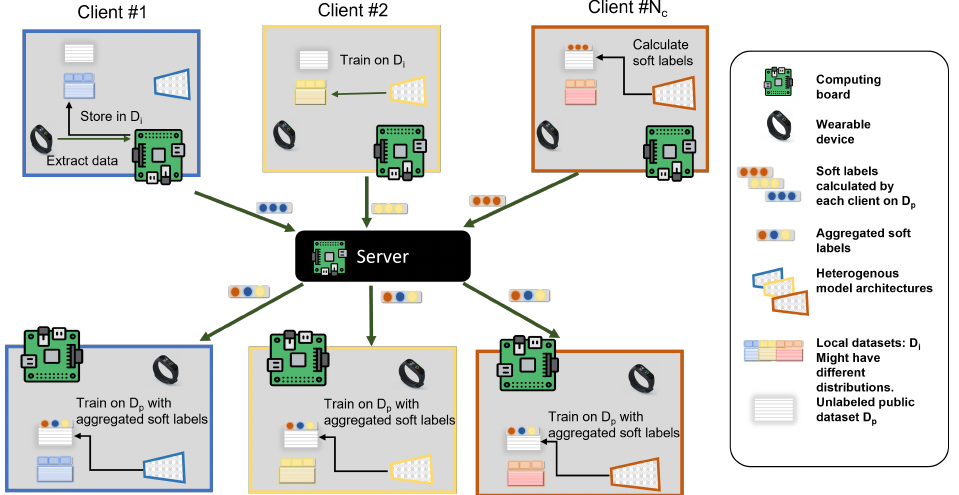
Figure 5. An overview of the proposed heterogeneous federated learning with knowledge distillation architecture. Each client owns a local dataset, an independently designed model, and a shared dataset. By utilizing knowledge distillation, clients use the shared dataset to transfer the knowledge they learned from local datasets by communicating their soft labels on the shared dataset with all clients. We propose an additional step where the shared dataset D p is augmented to be D r enhance